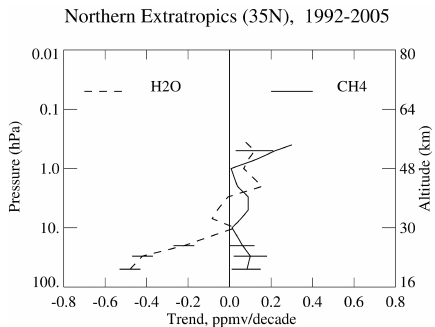
Figure 11. Trend profiles (in ppmvdecade − 1 ) for CH 4 and H 2 O at 35 ◦ latitude in the Southern Hemisphere. Horizontal bars denote the 2 σ uncertainties for the highly significant trends.